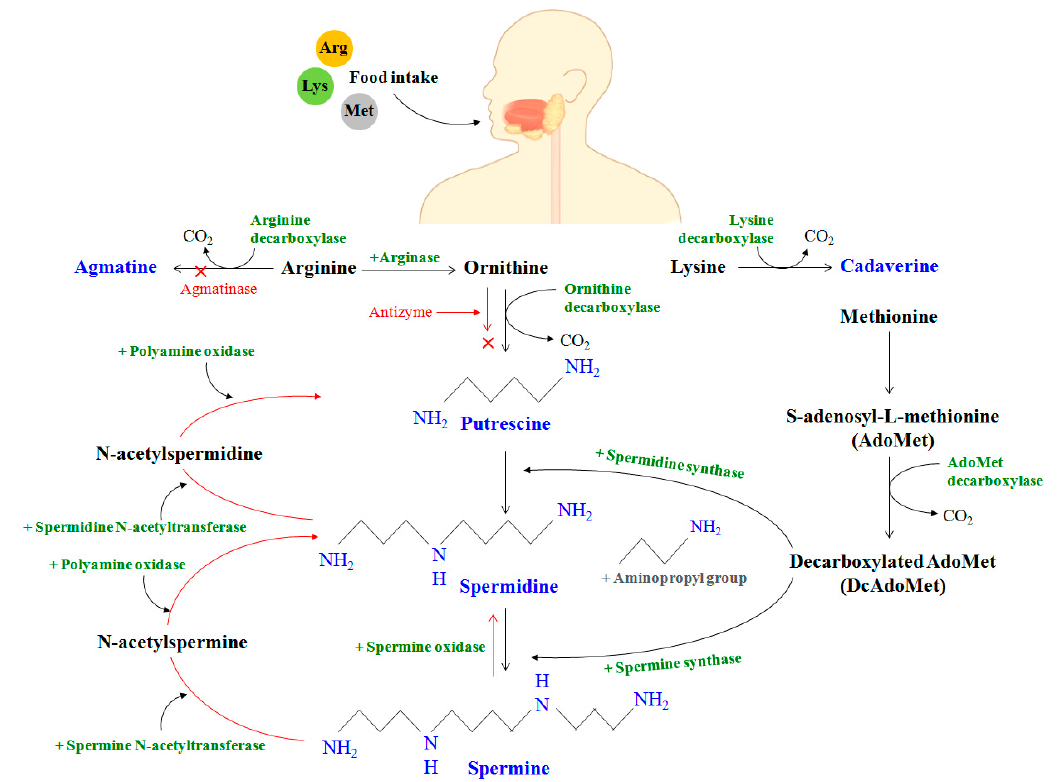
Figure 3. Polyamine synthesis (black/blue) and regulatory (red) pathways in the human gut after ingestion of amino acids: arginine (Arg), lysine (Lys), and methionine (Met).